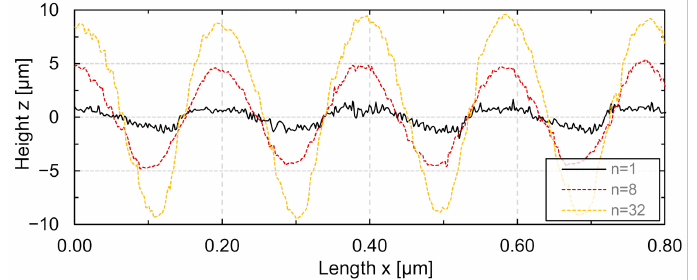
Figure 10. Longitudinal section of single track after surface structuring using n = 1, 8, and 32 passes ( d L = 50 µ m, v scan = 400 mm/s, λ = 0.2 mm, P M = 14.5 W and P A = 5.5 W adapted to v scan